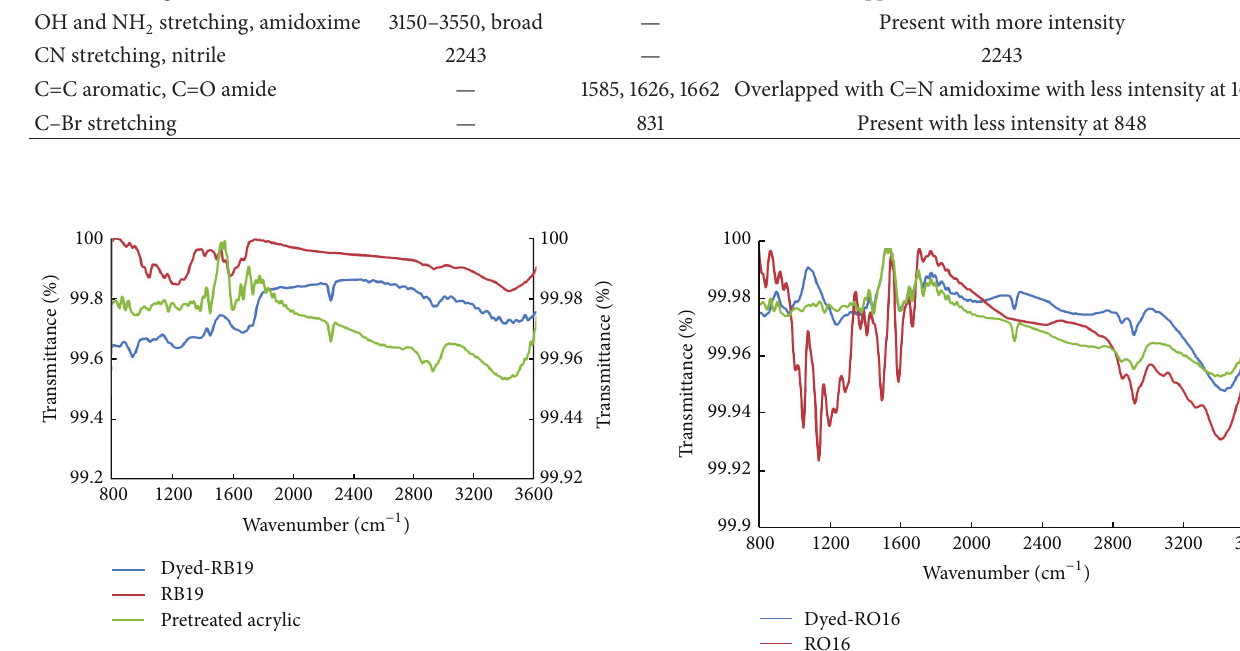
Figure 7: FTIR of amidoximated acrylic fibres, RB19, and amidox- imated acrylic fabrics dyed with RB19; dyeing conditions: shade 2% owf, liquor ratio 40 :1, pH 2.5, at 100 ∘ C for 60min. Figure 8: FTIR of amidoximated acrylic fibres, RO16, and amidox- imated acrylic fabrics dyed with RO16; dyeing conditions: shade 2% owf, liquor ratio 40 :1, pH 2.5, at 100 ∘ C for 60